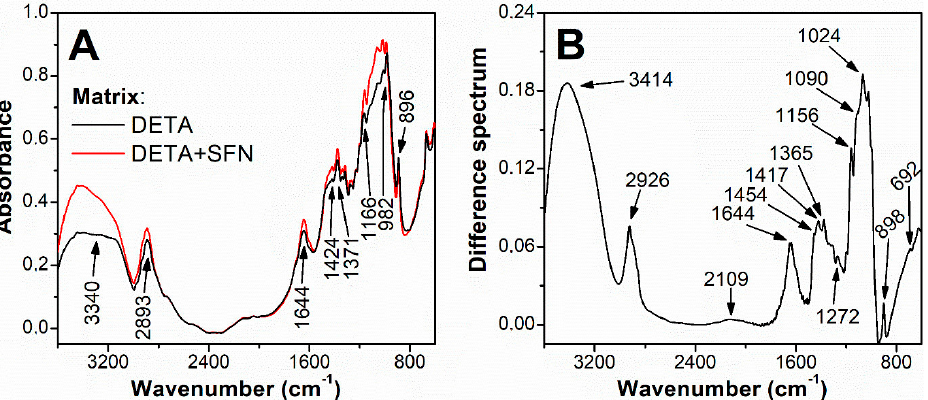
Figure 2. The FTIR spectra of DETA and DETA with covalently bound SFN ligand ( A ); and the difference spectrum ( B ). Samples were prepared in the form of KBr pellets (3 mg of samples combined with 300 mg of KBr). Infrared spectra were measured on a FTIR spectrophotometer Varian Excalibur Digilab FTS 3000 MX (Palo Alto, CA, USA) in the range of 4000 to 600 cm − 1 . The spectrum of the pure KBr pellet was used as the background reference. The IR absorption maxima are specified by arrows. After loading the protein fraction obtained at 45% saturation of AS onto the column filled with the DETA + SFN resin, the column was first washed by the equilibration medium (EQM) to elute unbound material and then sequentially washed by the EQM containing three different stripping agent, 2M KCl, 0.5% ( v/v ) Triton X-100 and 1M guanidine thiocyanate, particularly, to elute bound proteins (Figure 3A).